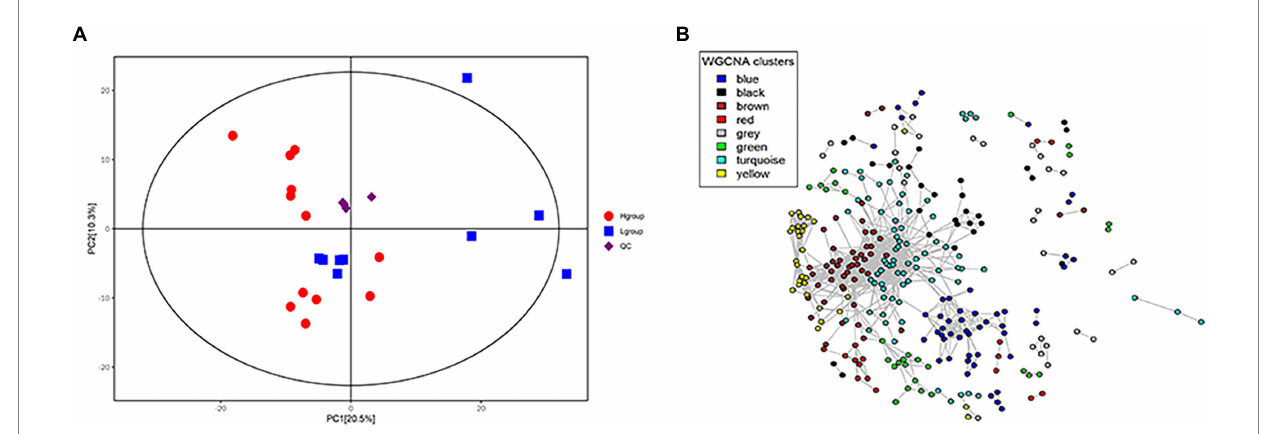
FIGURE 5 Differentiation of host serum metabolite profiles between H-group ( n = 12) and L-group ( n = 9) Qiandongnan Xiaoxiang chickens at 160 ± 3 days of age. (A) PCA plot of serum metabolite profiles (B) Co-occurrence network of serum metabolite features. The metabolites (nodes) are colored according to WGCNA module colors. Only those correlations with | r | > 0.2 between two edges are presented.